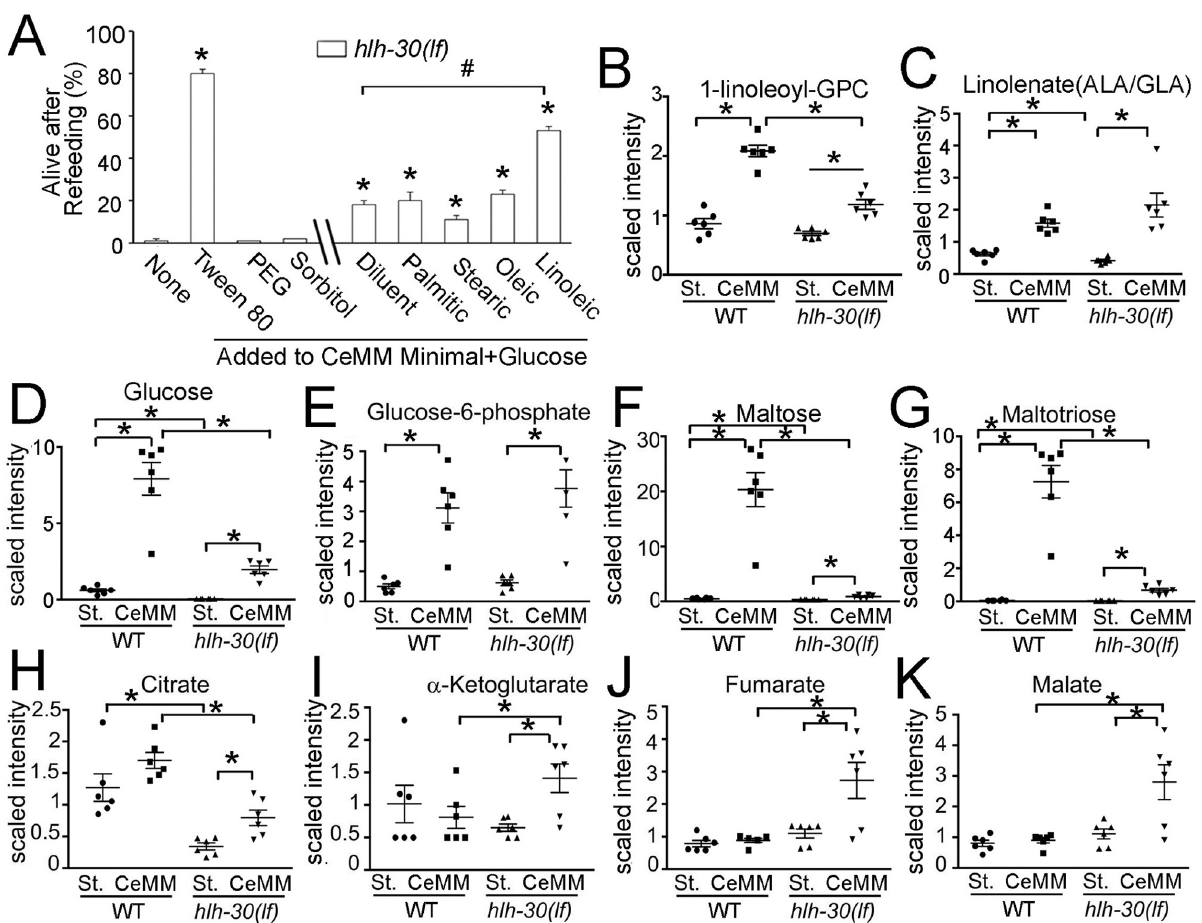
Fig 3. Metabolomic profiling reveals linoleic acid, a CeMM component, as essential for rescue of starved hlh-30(lf) worms. (A) hlh-30(lf) worms were analyzed after 33 hours of starvation and 15 hours of exposure to modified formulations of CeMM, followed by 48 hours on E . coli OP50 (as in Fig 2A). CeMM minimal solution lacking glucose, β -sitosterol in Tween 80, amino acids, and nucleic acids was supplemented with glucose and individual nutrients shown below. N = 3 replicates of 50 worms each. A mixture of BSA and ethanol was used to solubilize fatty acids and tested as a control (labeled as diluent). Bars indicate mean ± SEM. � P < 0.05 versus none and # P < 0.05 versus diluent by post hoc test after one-way ANOVA. (B–K) WT and hlh-30(lf) worms were subjected to 33 hours of starvation (St.) or worms were refed with CeMM for 15 hours following the 33 hours of starvation (CeMM). Abundance of 1-linoleoyl-GPC (B), linolenate (C, both α - and γ -linolenic acid, ALA or GLA), glucose (D), glucose-6-phosphate (E), maltose (F), and maltotriose (G) and tricarboxylic cycle metabolites, namely citrate (H), α -ketoglutarate (I), fumarate (J), and malate (K) was assessed as scaled intensity (please see Methods for details). N = 6 biological replicates/group. Bar and whisker indicate mean ± SEM. � P < 0.05 by post hoc test after two- way ANOVA. Raw data for A–K are in S1 Data. BSA, bovine serum albumin; CeMM, C . elegans maintenance medium; hlh-30 , basic helix–loop–helix transcription factor 30; hlh-30(lf) , loss-of-function tm1978 mutation hlh-30 ; linoleoyl-GPC, linoleoyl glycerolphosphocholine; SEM, standard error of the mean; WT, wild type.